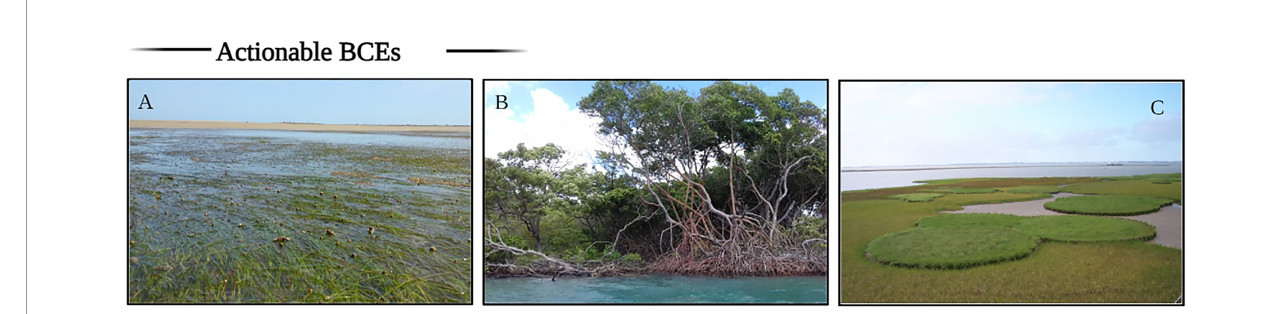
FIGURE 2 | Blue carbon ecosystems in Brazil (South Atlantic). (A) Seagrass meadows - Cajueiro da Praia - Piaui state. Photo: K. Barros; (B) Mangrove forest - Rio Acarau - Ceara state. Photo: R. C. Maia; (C) Salt marshes - Lagoa dos Patos - Rio Grande do Sul state. Photo: